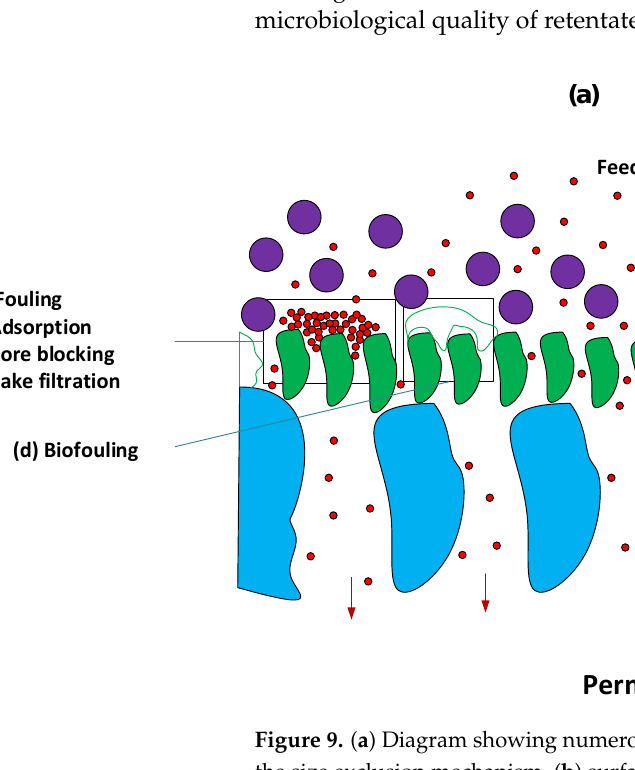
21 of 48 Figure 8. Separation by size-based exclusion ( a ) and dissolution – diffusion ( b ) methods.